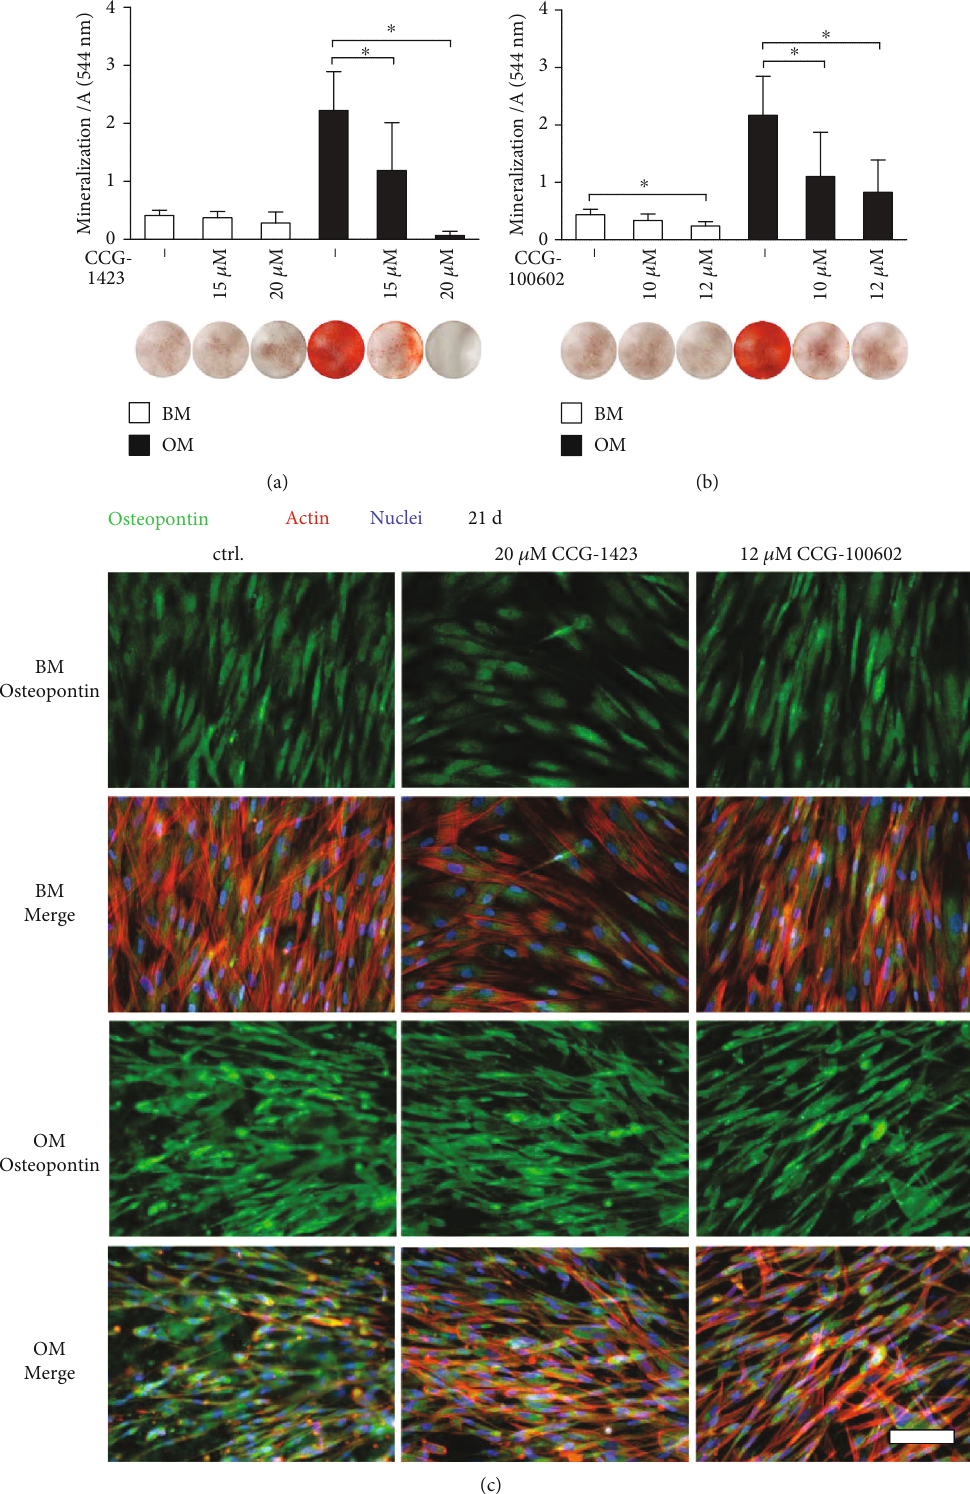
Figure 4: Late osteogenesis of MRTF-A inhibitor-treated hASCs. Matrix mineralization of hASCs was analyzed with AR staining after 21d of culture with CCG-1423 (a) or CCG-100602 (b) inhibitors. Quantitative results of AR staining are presented as graphs, and corresponding representative images of the stained wells (area 1.9cm 2 ) are displayed below the columns, bright red dye represents mineral. N = 9 , independent biological replicates from 3 donors. Signi fi cance level 5%. (c) Representative OPN-stained samples of MTRF-A inhibitor-treated hASCs at 21d. The cells were imaged with a fl uorescence microscope using Alexa 488 for OPN (green), Alexa 546 for actin (red), and DAPI (blue) fi lters, and 20x magni fi cation. Scale bar 100 μ m, same scale in every image. BM: basic medium; OM: osteogenic